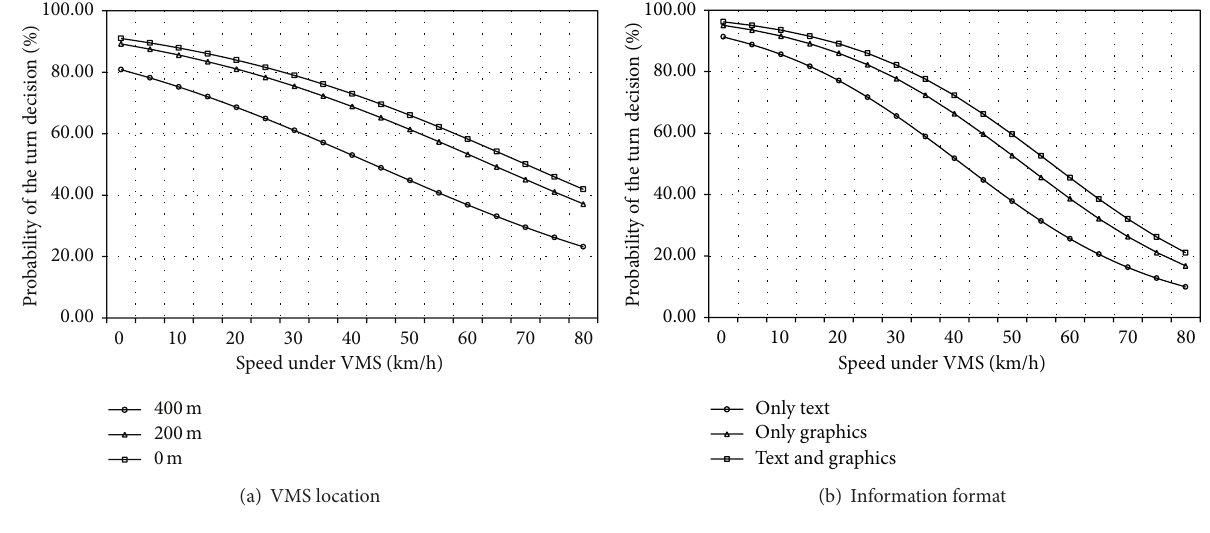
Figure 4: Probability of turn decision based on the logistic regression models.